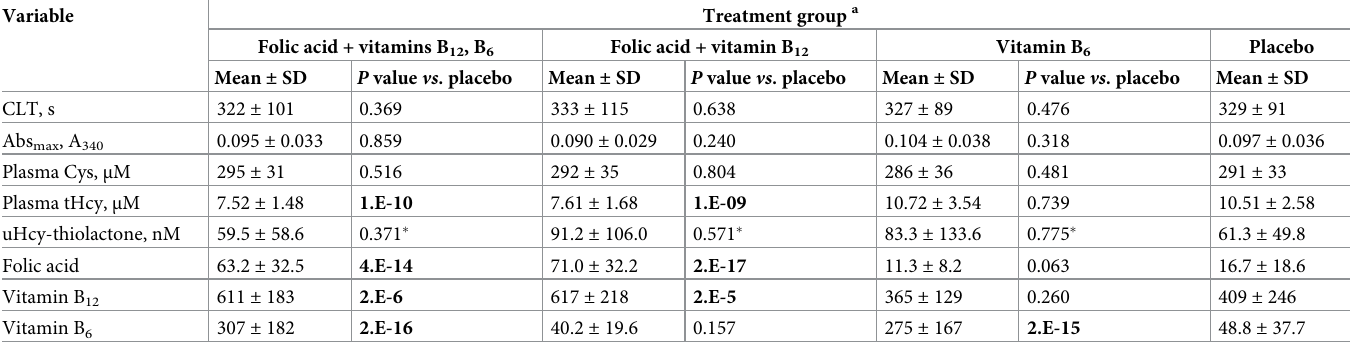
Table 4. Plasma fibrin clot lysis time (CLT) and maximum absorbance (Abs max ) at the end of study according to folic acid and B-vitamin supplementation status.